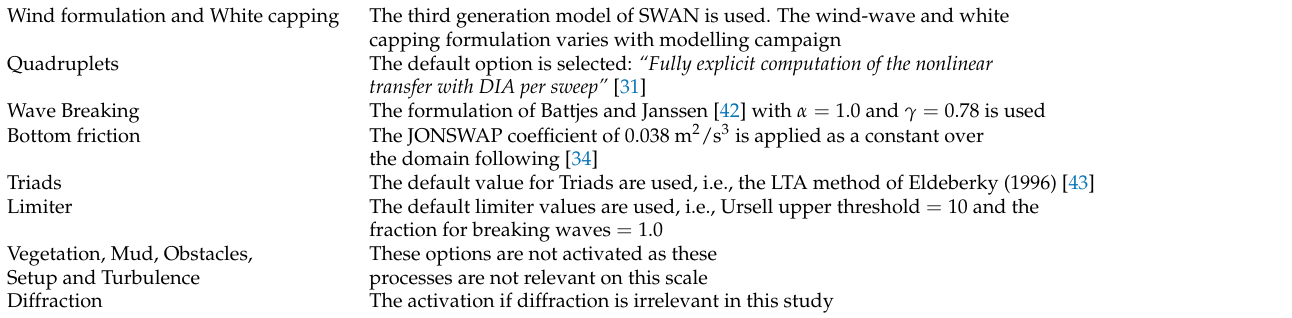
Table 3. Physical parameters used in the SWAN model setup.